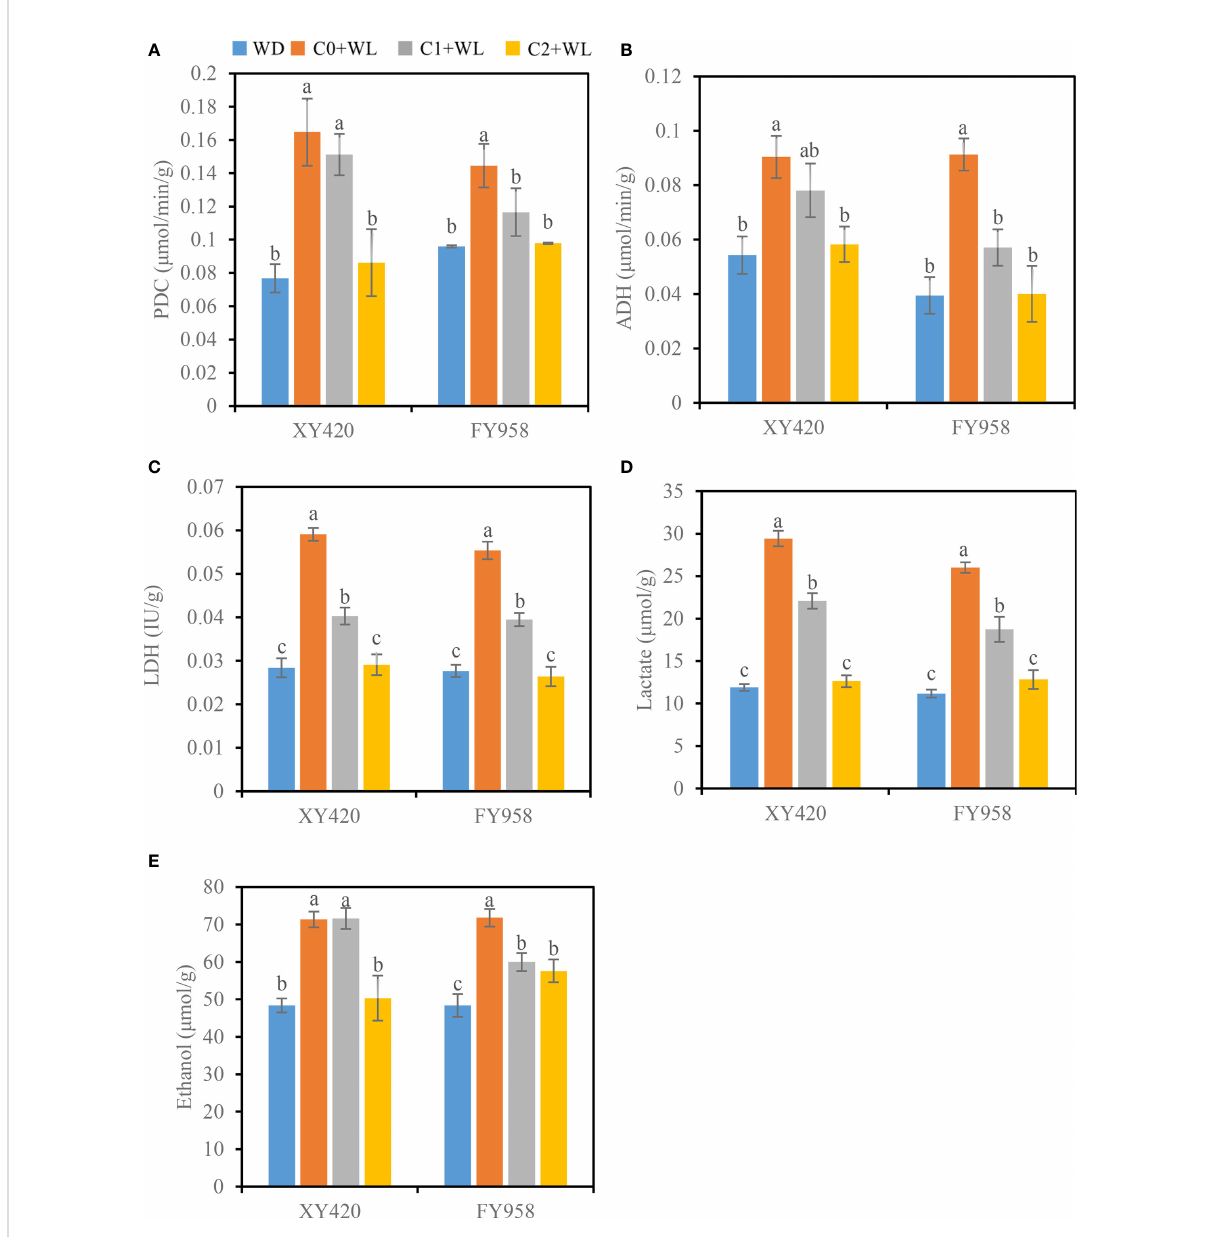
FIGURE 4 Effects of CaO 2 on the activities offermentative enzymes and fermentation products in roots under waterlogging conditions. (A) , PDC, pyruvate decarboxylase; (B) , ADH, alcohol dehydrogenase; (C) , LDH, lactate dehydrogenase; (D) , lactate; (E) , ethanol. Error bars represent standard errors. Different letters above bars indicate signi fi cant differences between planting patterns at P < 0.05. WD, well-draining, C0+WL, no CaO 2 and waterlogging, C1+WL, 594 kg hm -2 of CaO 2 in the form of base fertilizer and waterlogging, and C2+WL as in treatment C1+WL but a supply of 864 kg hm -2